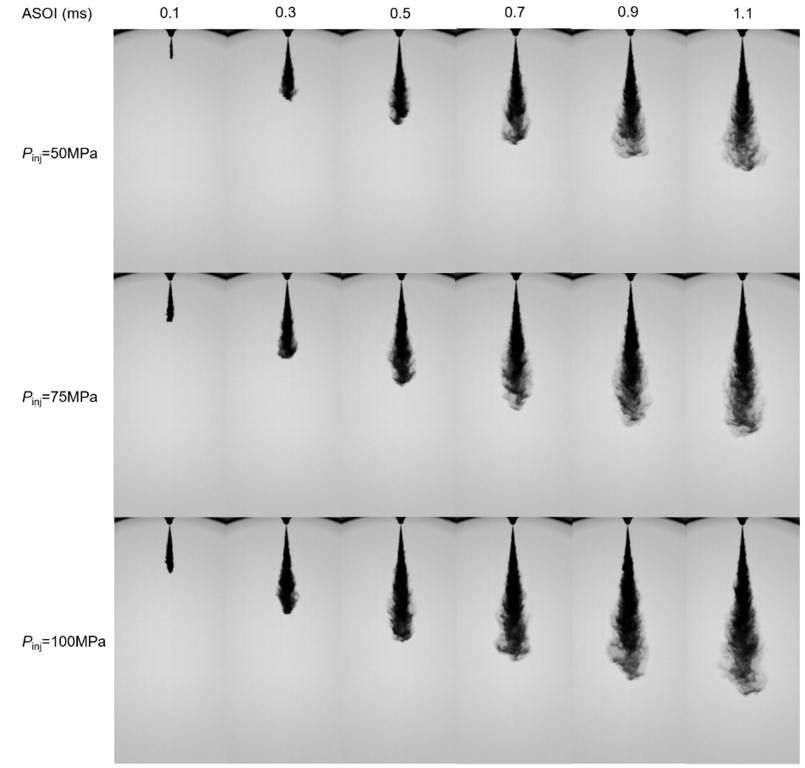
amb = 4 MPa. Fuel: liquid